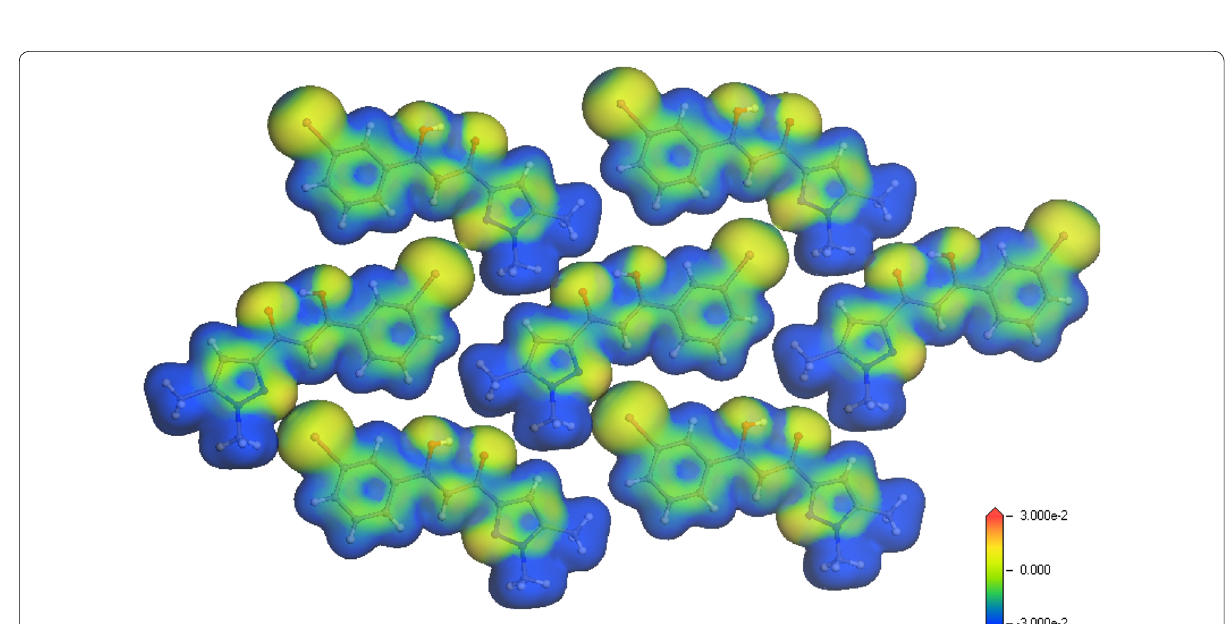
Fig. 4 Representation of the 3D isosurface electron density (volumic contour) mapped with the deformation density. Positive value (yellow domains) indicate electron